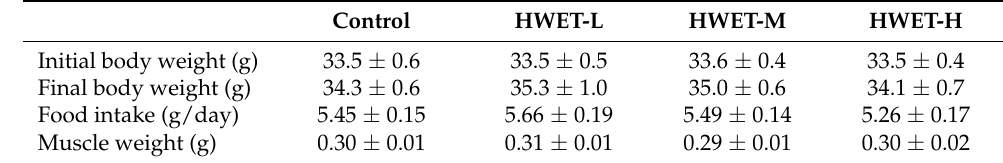
Table 2. A summary of body weight, food intake, and skeletal muscle